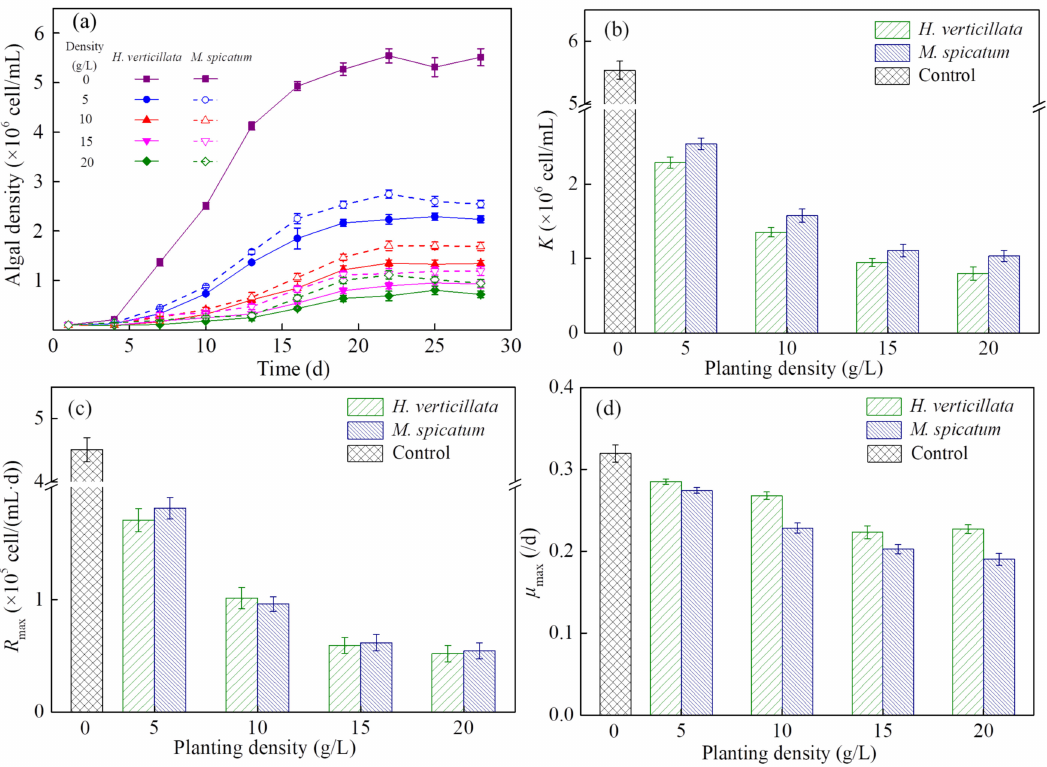
Figure 1. Changes in the ( a ) growth curve, ( b ) maximum algal biomass, K , ( c ) maximum population growth rate, R max and ( d ) maximum specific growth rate, µ max of algae with changes in planting density from 0 to 20 g / L. Results are expressed as average ± SD ( n =